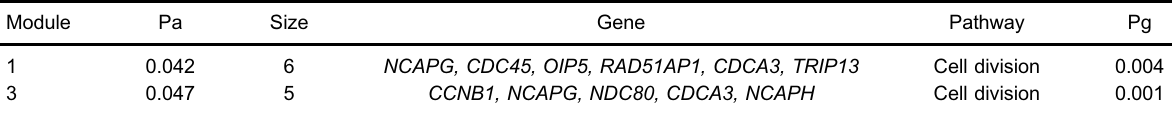
Table 1. Details of the differential